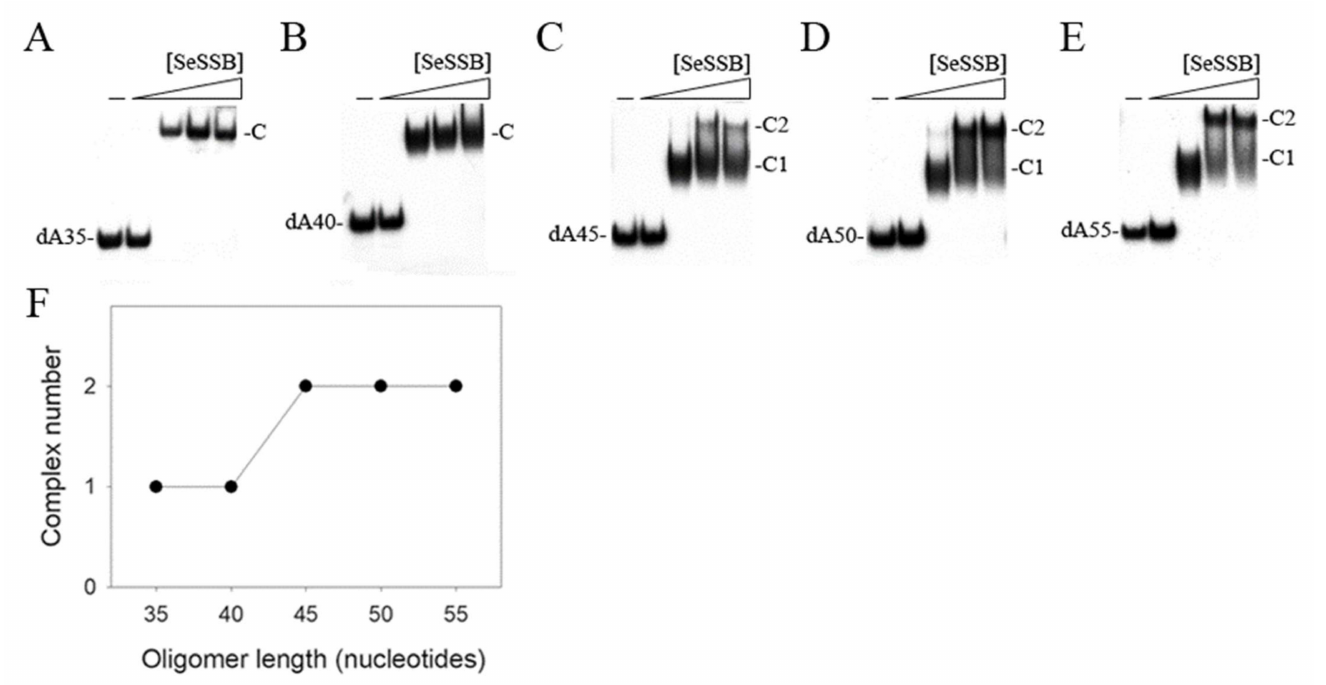
Figure 3. EMSA of SeSSB. The SeSSB protein (0, 500, 1000, 2000, and 4000 nM) was incubated at 25 ◦ C with 1.7 nM of ( A ) dA35, ( B ) dA40, ( C ) dA45, ( D ) dA50, or ( E ) dA55. The resulting samples were resolved on a native 8% polyacrylamide gel at 4 ◦ C in TBE buffer (89 mM Tris borate and 1 mM EDTA) for 1 h (for analyzing dA35 and dA40) or 1.5 h (for dA45–55) at 100 V and visualized by autoradiography. ( F ) Summary of the complex number of the